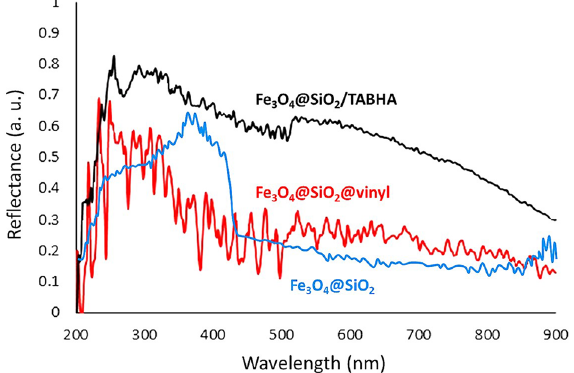
Figure 7. UV–DRS curves of Fe 3 O 4 @SiO 2 (blue), Fe 3 O 4 @SiO 2 @vinyl (red), and Fe 3 O 4 @SiO 2 /TABHA NPs